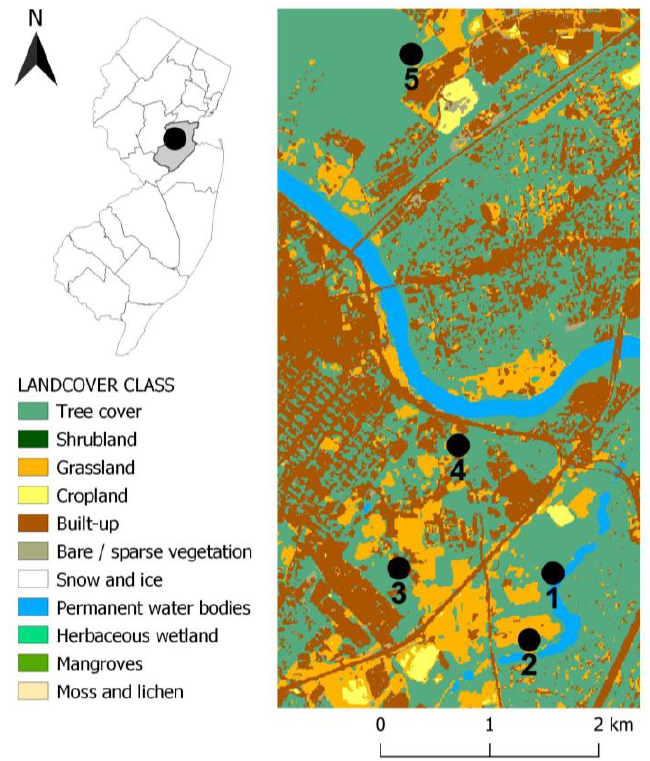
Figure 1. Map of sampling sites in the study area (Middlesex, NJ). QGIS map base ESA World Cover [19].